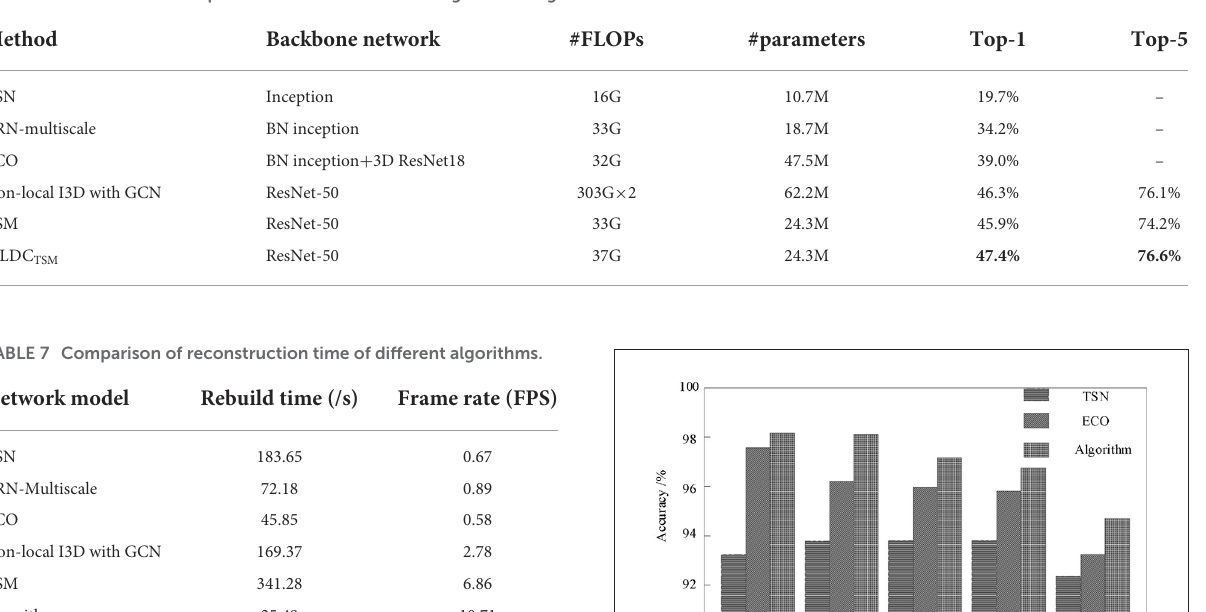
TABLE 6 Performance comparison of MLDC on something-something V1 dataset.